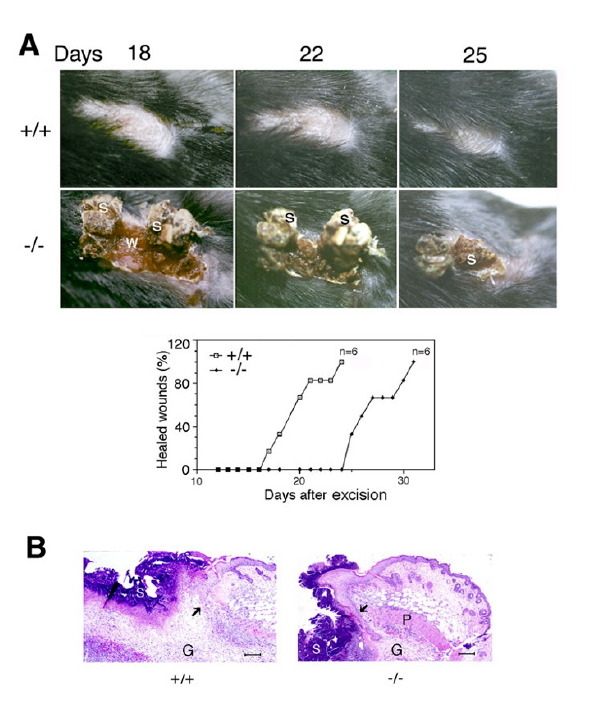
Figure 1 Healing of 25 mm oblong skin wounds (A) and histology of 6 mm circular skin wounds (B) in wild-type (+/+) and SPARC- null (-/-) mice. In (A) upper panel: an example of the progress of repair processes at the indicated times (days) is shown. S: scab; W: open wound field. In (A) lower panel: percent of wild-type and SPARC-null mice (6 in each group) with healed wounds, defined as loss of the wound scabs and complete covering of the wounds with epidermis, is plotted versus days after the excision. Panel (B) illustrates histologic appear- ance of 6-mm wounds in a wild-type (+/+) mouse and an SPARC-null (-/-) mouse 4 days after surgery. Granulation (G) tissue formation is more extensive in the wild-type mouse than in the SPARC-null mouse. Arrows indicate reepithelial- ized wound edge. Reepithelialization appears to be as effi- cient in mutant mice as in control mice. S: scab; P: panniculus carnosus. Hematoxylin and eosin staining. Scale bar, 210 µ